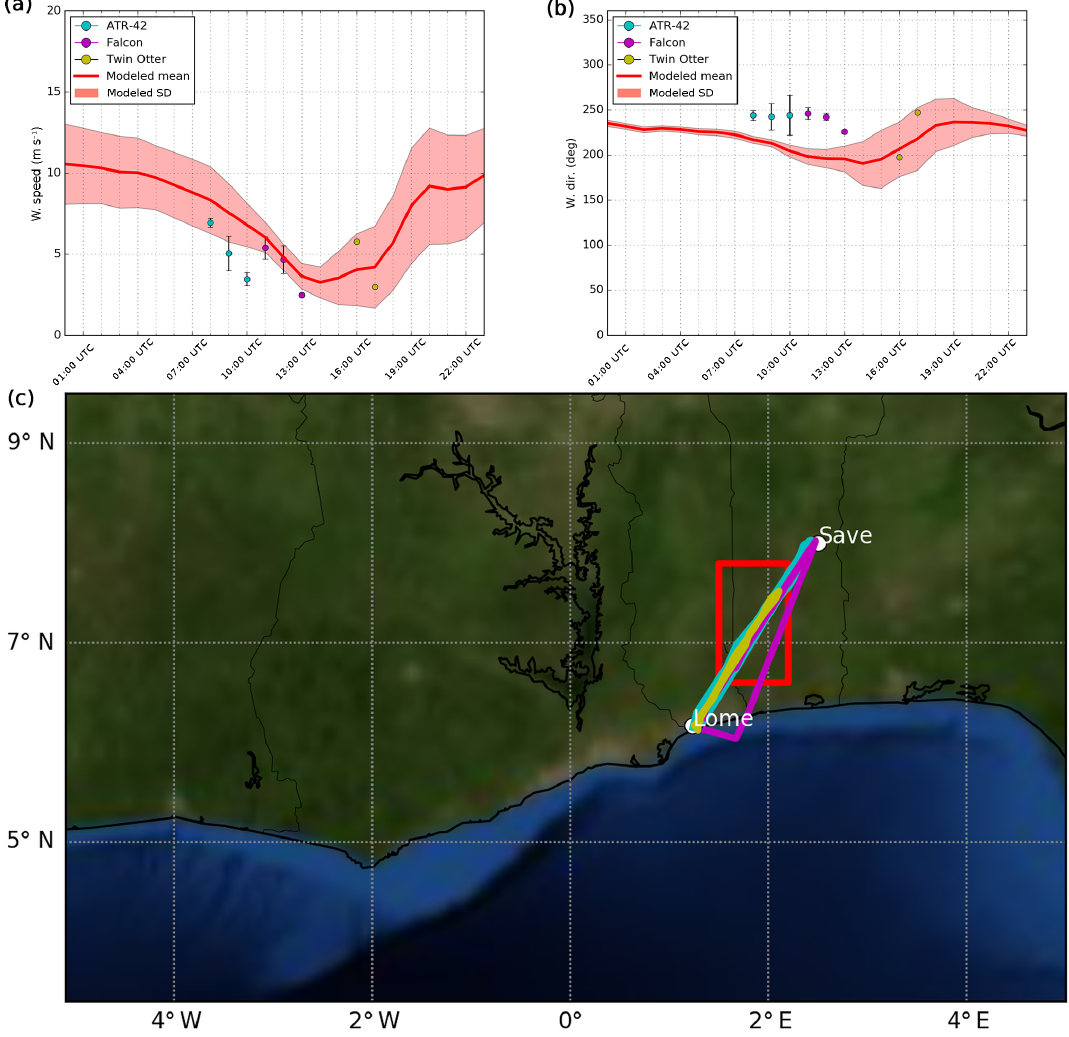
Figure A3. Wind speed (a) and direction (b) hourly averages and standard deviations on 5 July 2016 for all aircraft measurements (dots and error bars) acquired in a box (latitude from 6.6 to 7.8 ◦ N, longitude from 1.5 to 2.2 ◦ E, at an altitude from 300 to 1000m). The horizontal extent of the box and the aircraft tracks are displayed on the map (c) . Modeled value averages of the whole box are presented by the red line (and standard deviation by red shading). Blue dots correspond to ATR 42 measurements, violet to Falcon, and yellow to Twin